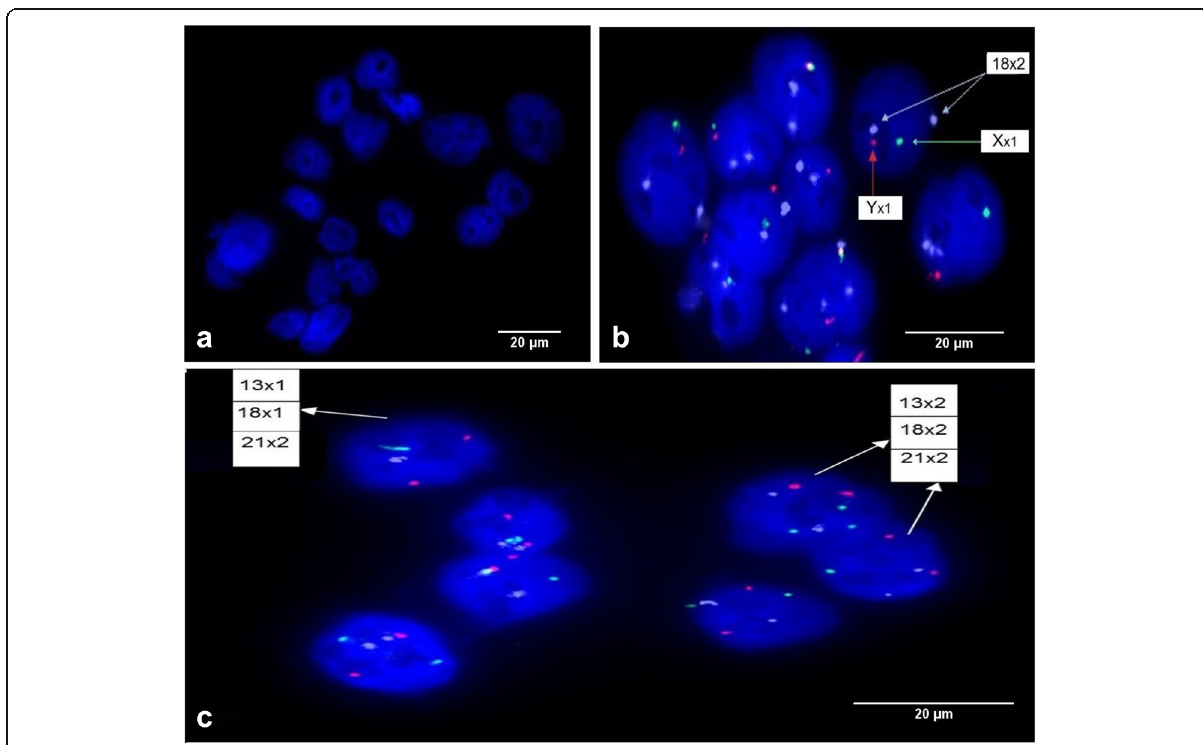
Fig. 4 Preimplantation genetic testing for aneuploidy (PGT-A) of biopsied blastocysts obtained from surplus embryos applying FISH technique. The images showed normal nuclei: a stained with DAPI; b for chromosome X (green), chromosome Y (red), and chromosome 18 (blue) in first round; and c a blastocyst with mosaicism for chromosome 13 (green), and chromosome 18 (blue) using specific probes (Cytocell, OGT Company, Cambridge,